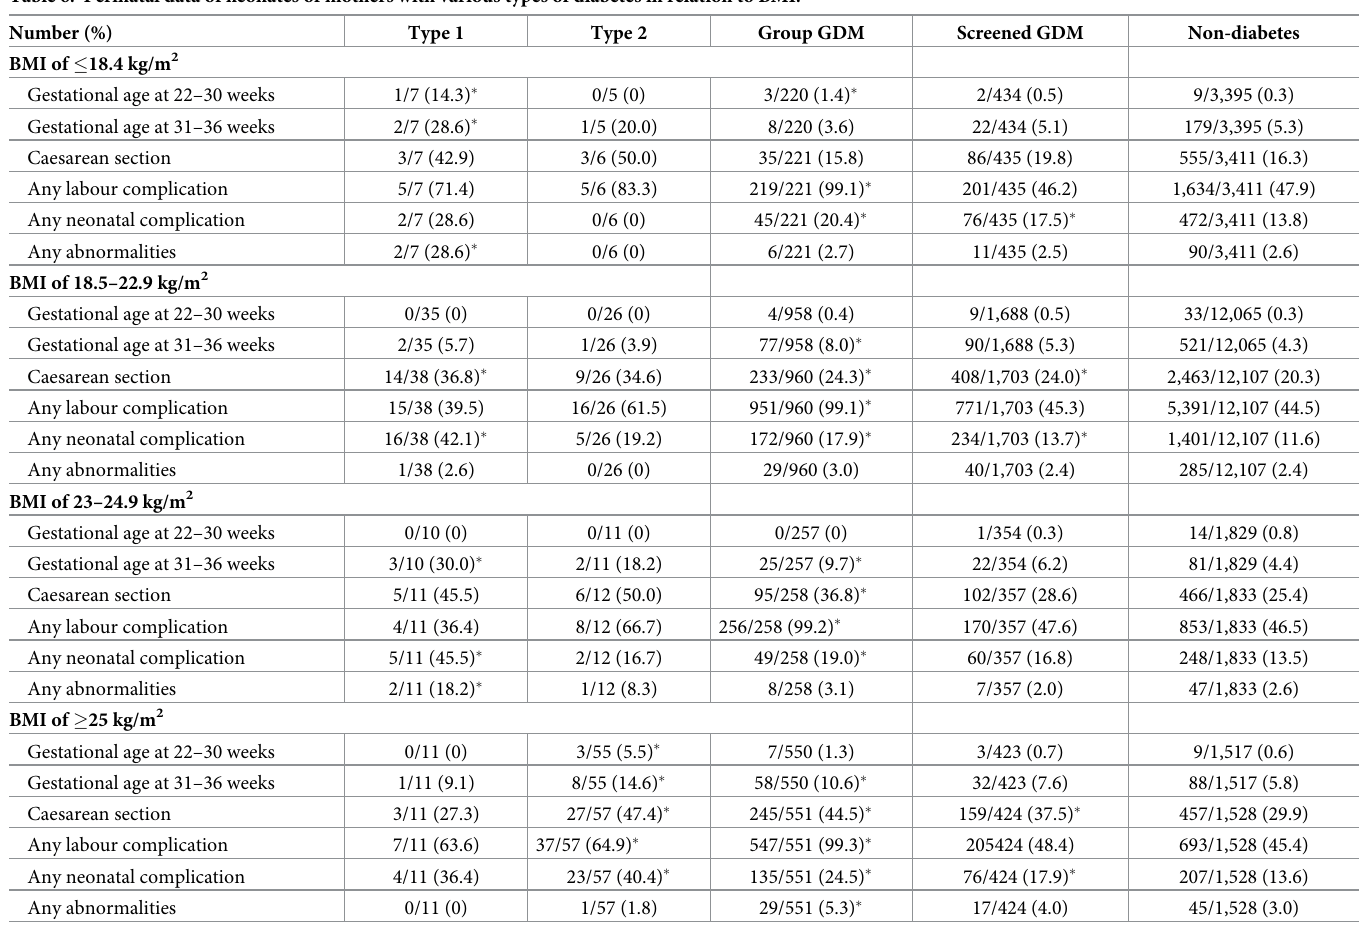
Table 6. Perinatal data of neonates of mothers with various types of diabetes in relation to